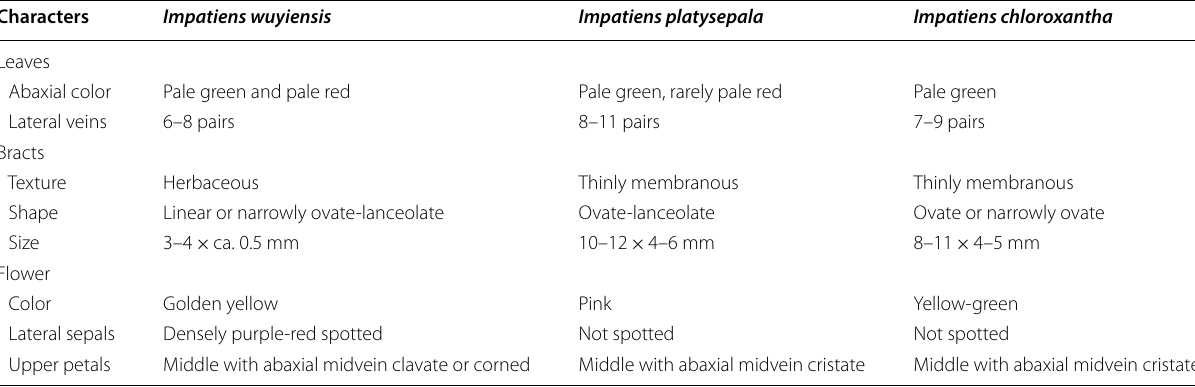
Table 1 Comparison of Impatiens wuyiensis , I. platysepala and I.